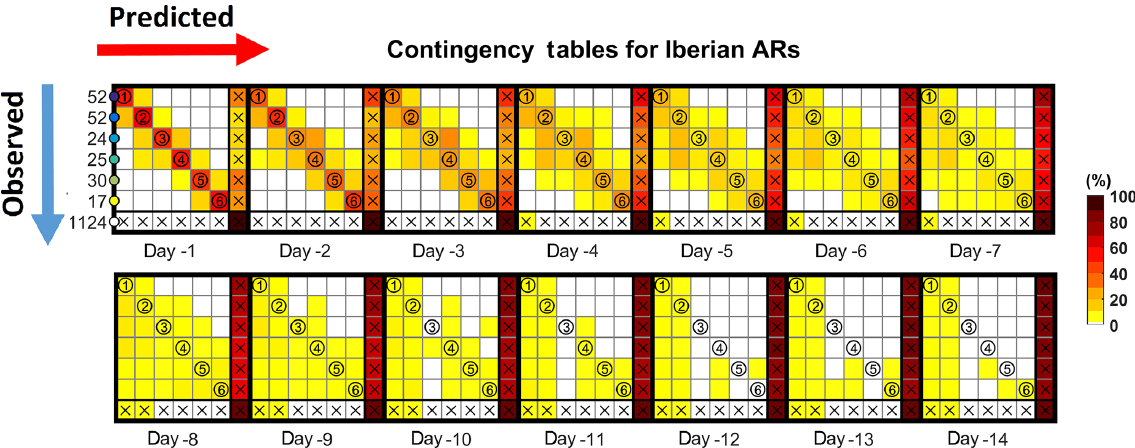
Figure 8. Contingency tables for the accuracy of AR-related IVT forecasts by the ECMWF ensemble system, for lead times ranging between 1 and 14d, during the winters spanning 2012–2016 are presented. The red shading represents the percentage of observations versus forecasts. Note that a perfect forecast system would only present shadings in the diagonal, as the y axis represents observed events in each box (as presented in Fig. 2) and the x axis represents forecasts in each box. The number of events in each box is shown in the y axis by the blue arrow. The last row and column represent (i) observations/forecasts outside of the six considered boxes and (ii) no AR observed/predicted,